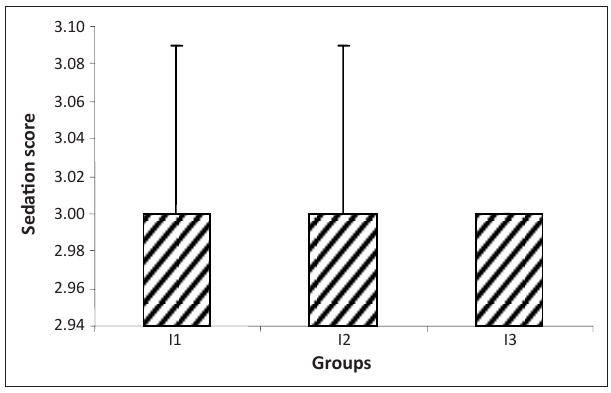
FIGURE 1: Median ± standard deviation of sedation in water buffaloes of different groups.